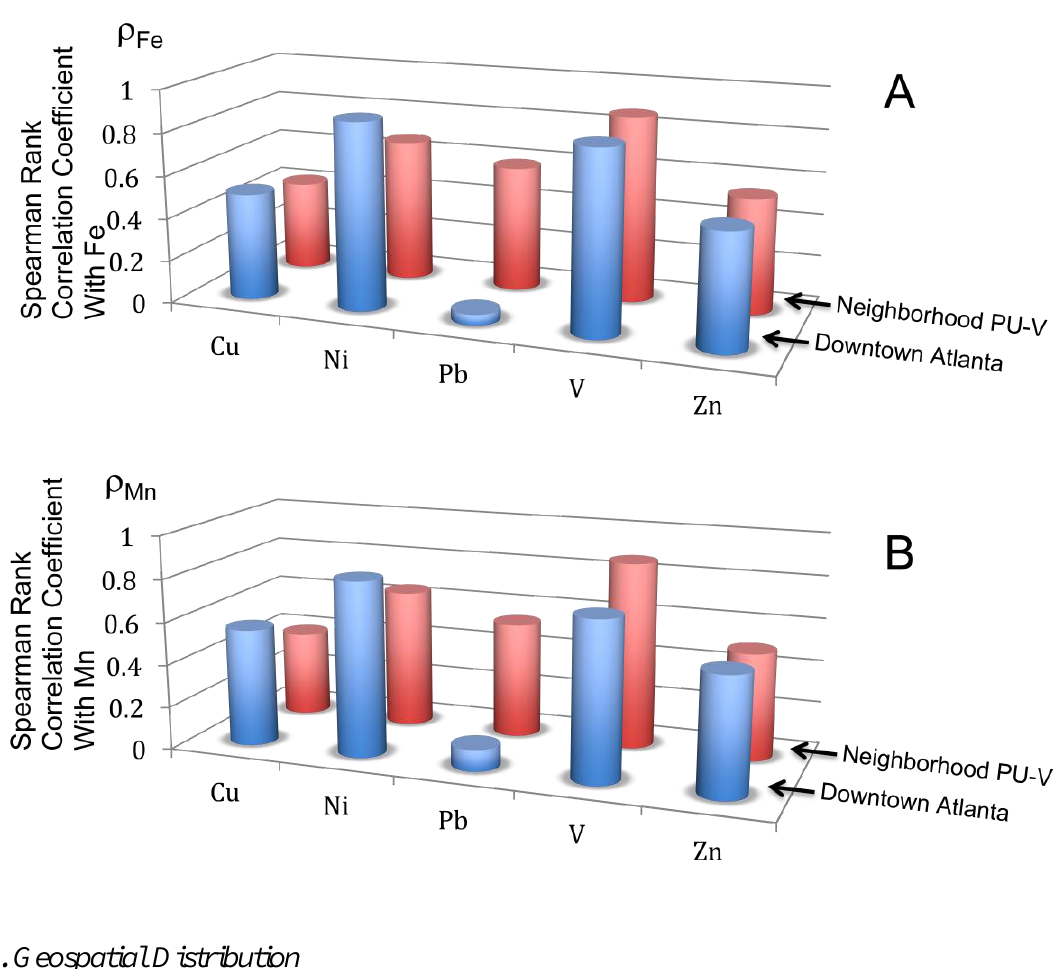
Figure 2. Spearman Rank Correlation Coefficients of metals with Fe ( A ) and Mn ( B